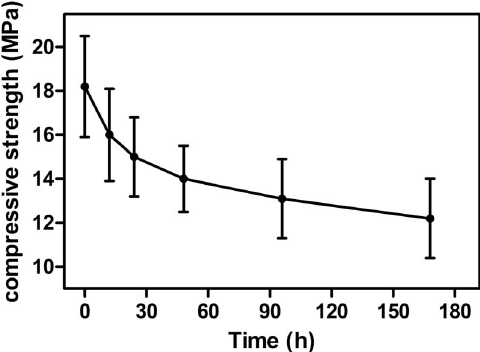
Figure 2. Compressive strength of vancomycin-loaded borate BG cement after hardening and as a function of immersion time in phosphate-buffered saline (PBS) invitro